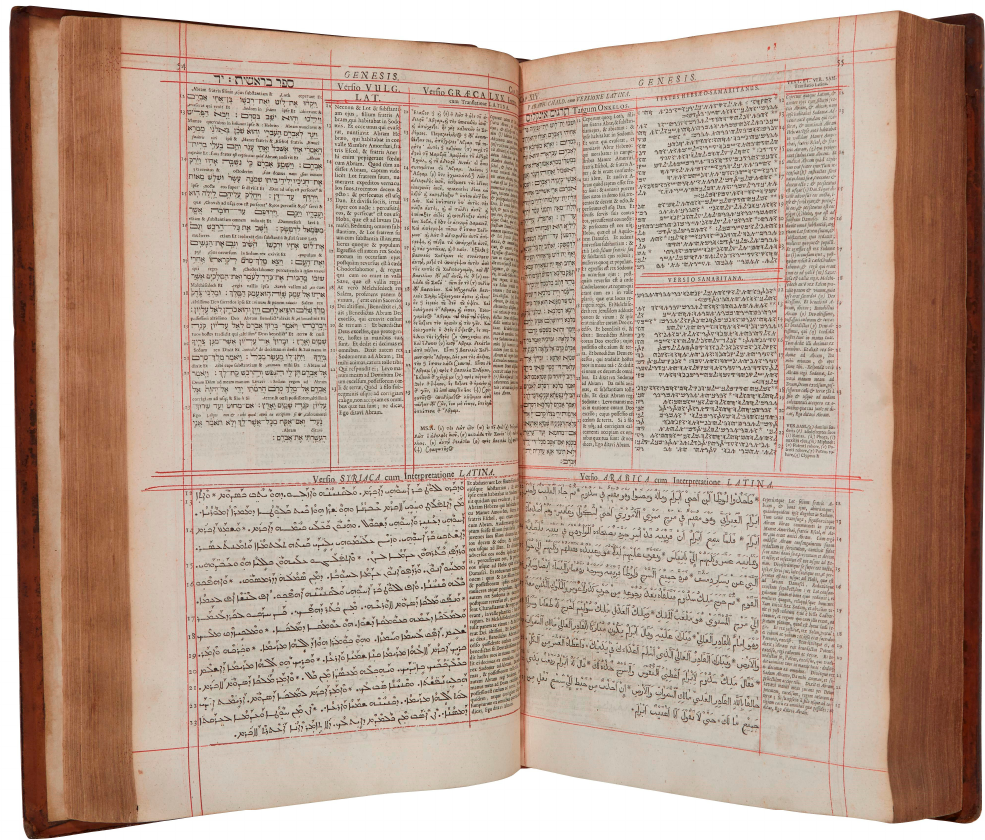
Figure 14. Walton Polyglot; Marsh’s Library A.2.2.